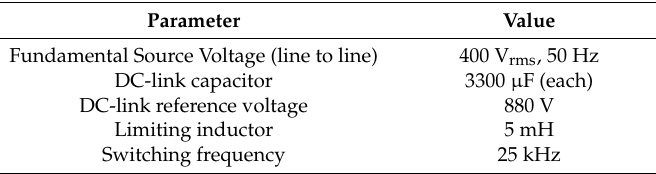
Table 1. Proposed parameters for SAPF.